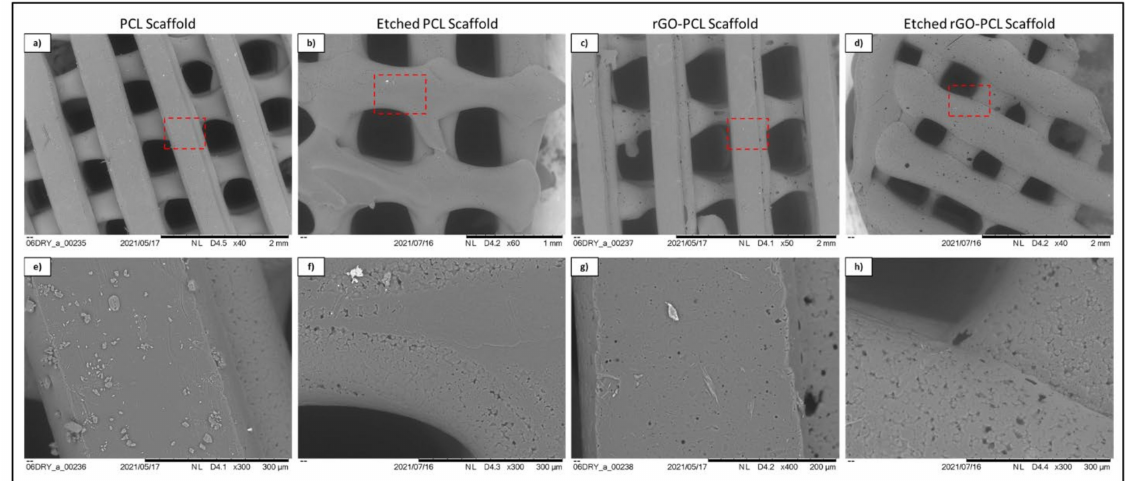
Figure 5. SEM imaging of etched ( b , d , f , h ) and unetched ( a , c , e , g ) PCL and rGO-PCL constructs at low ( a – d ) and high ( e – h ) magnification. Red dashed line boxes on low magnification images indicate the zone being magnified for each scaffold type.